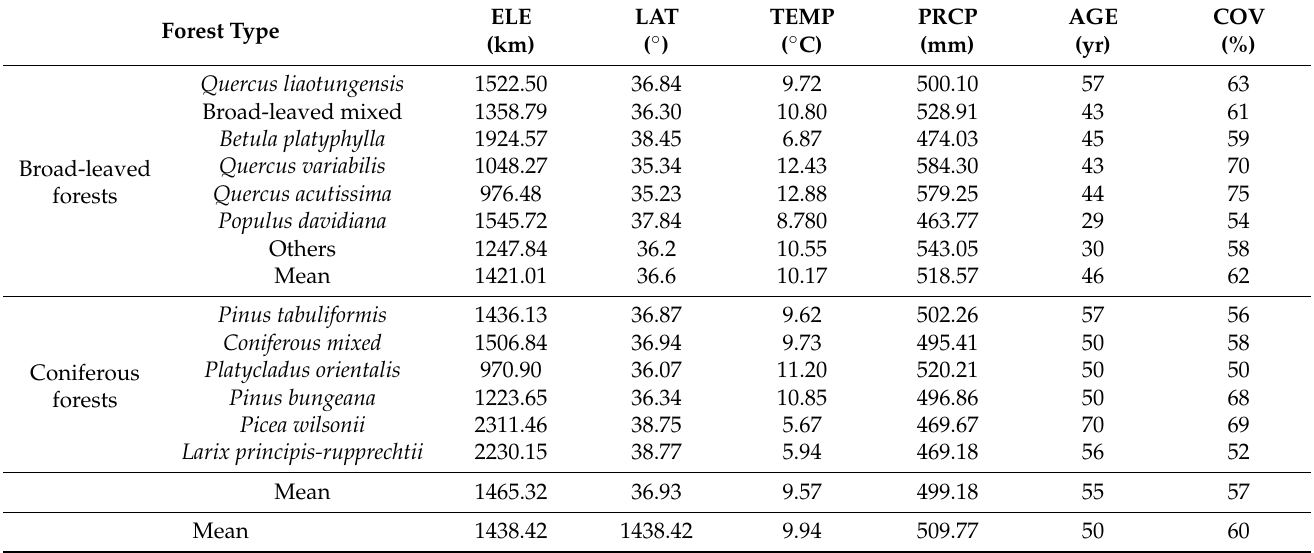
Table 1. Descriptive statistics of elevation (ELE), latitude (LAT), annual mean temperature (TEMP) and annual precipitation (PRCP), stand age (AGE), stand coverage (COV) for natural broad-leaved and coniferous forests in Shanxi, China.